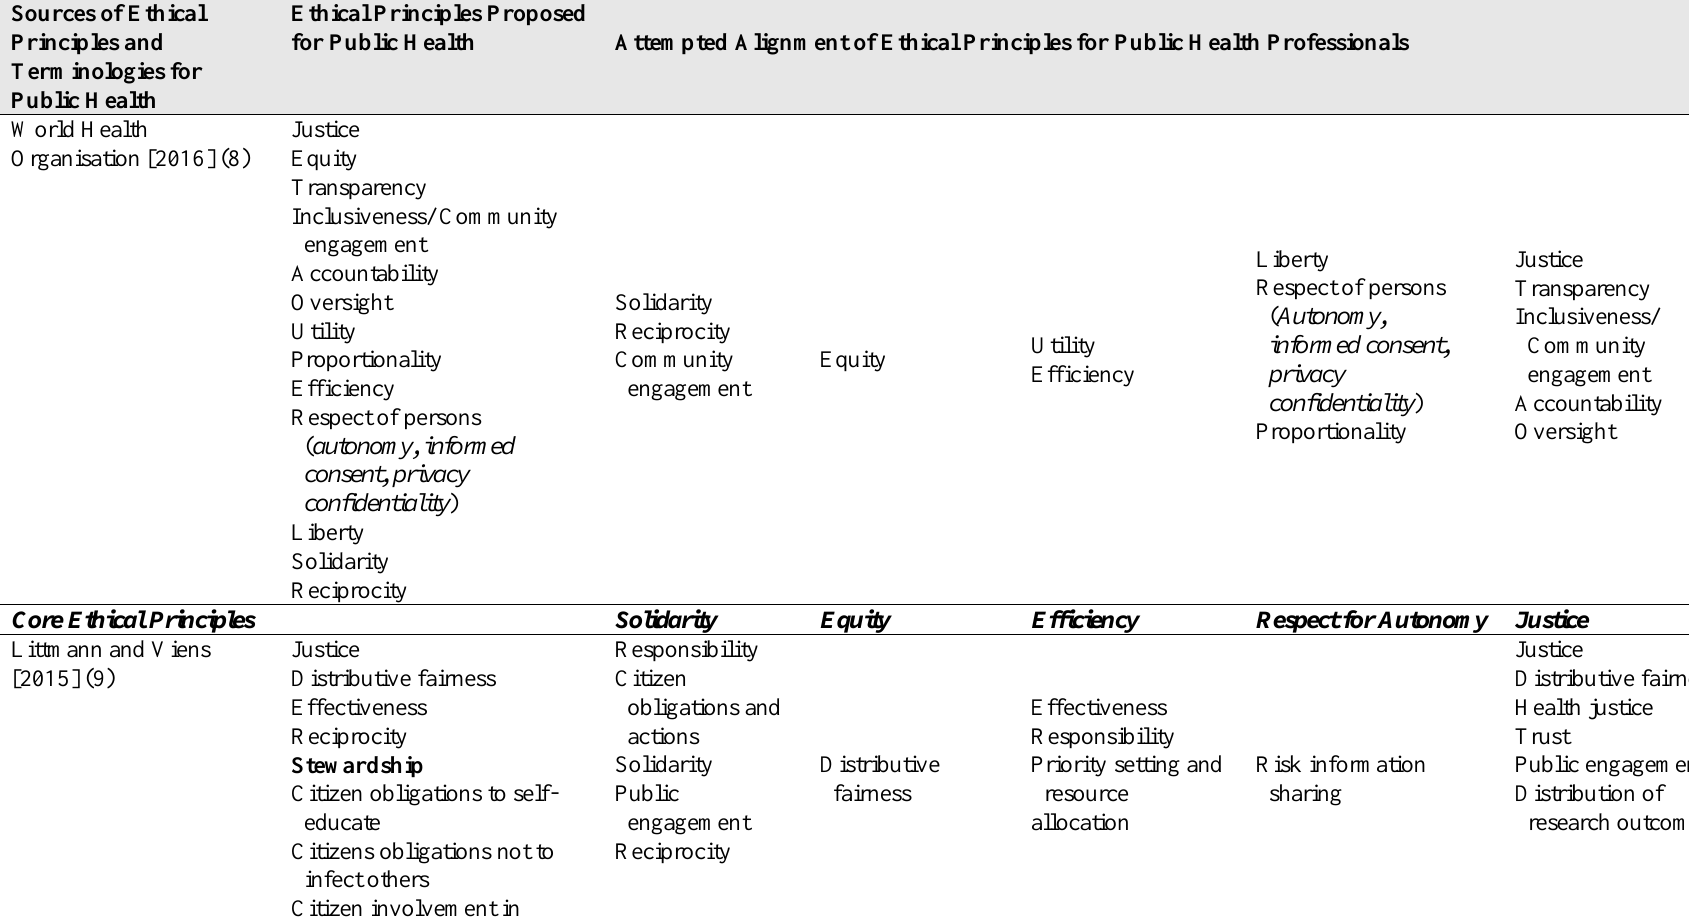
Table 1. Review of ethical principles and terminologies with relevance to public